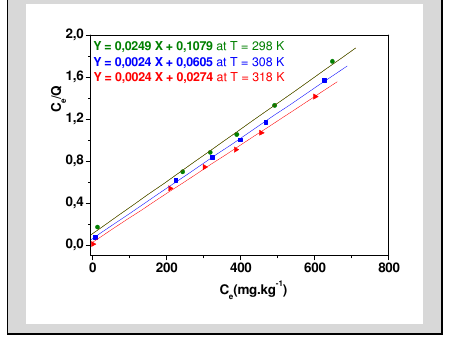
Fig. 9. Langmuir linear plot at 298 K, 308 K and 318 K.